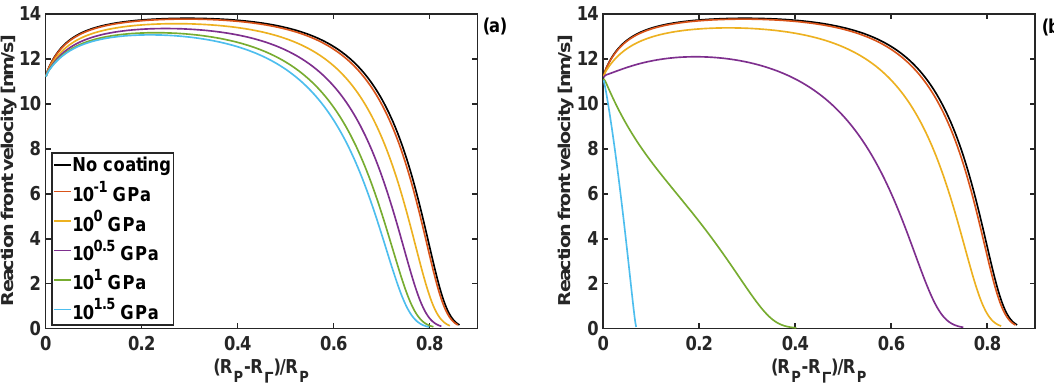
Figure 7: Profiles of reaction front velocity for different coating bulk moduli; (a) G Figure 7. Profiles of reaction front velocity for different coating bulk moduli. ( a ) G T = 1 GPa, h = 10 nm. ( b ) G T = 10 GPa and h = 10 nm. h=10 nm; (b) G =10 GPa and h=10 nm. T